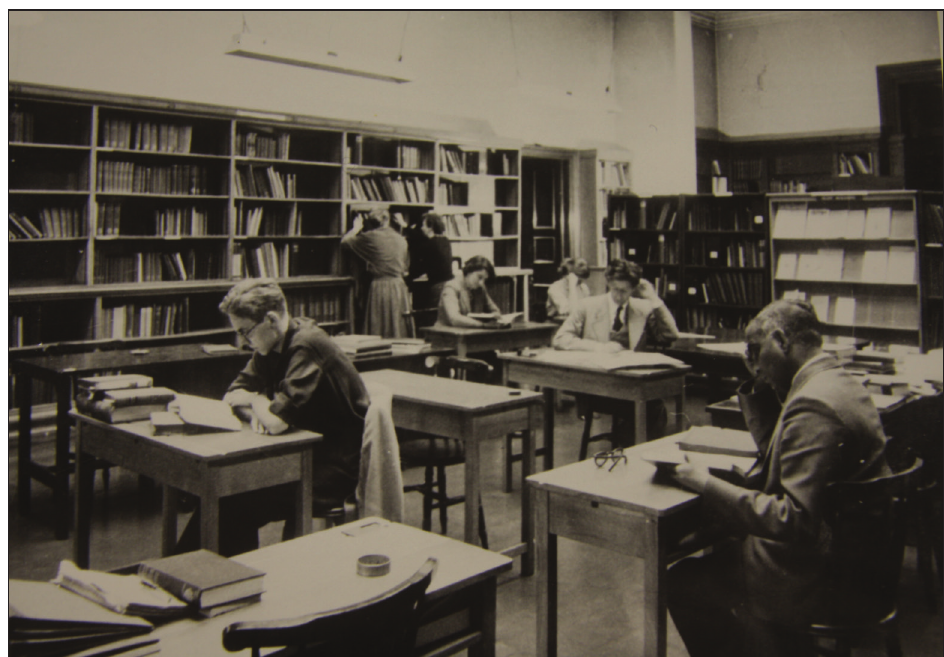
Figure 2: The St John’s Lodge Library. Taylor and Talbot with their backs to the camera, pictured shelving books together (Photo UCL Institute of